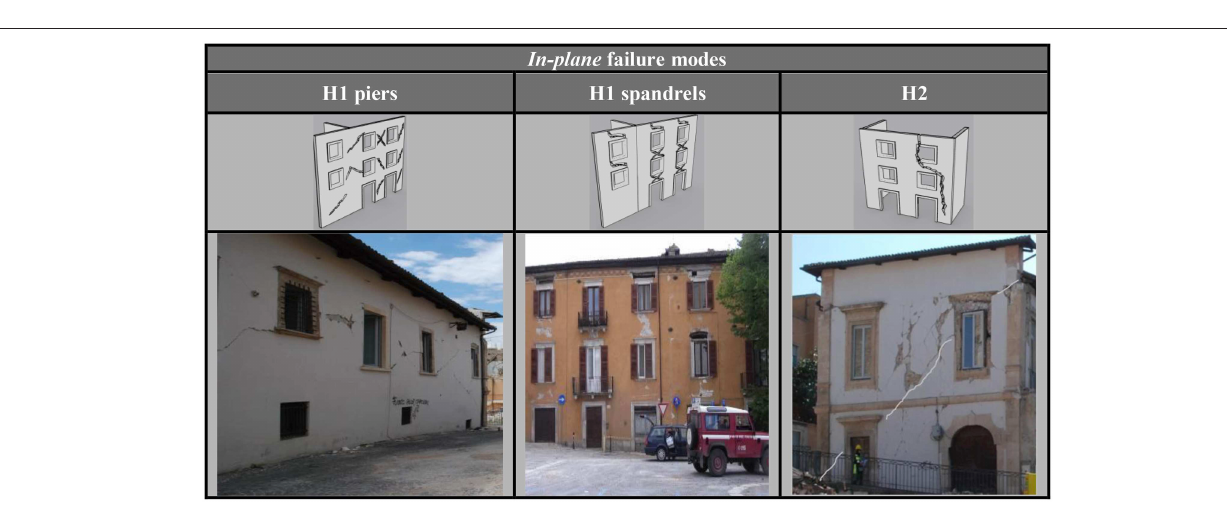
FIGURE 2 | On site identification of In-plane failure modes, adapted from D’Ayala and Paganoni (2011).